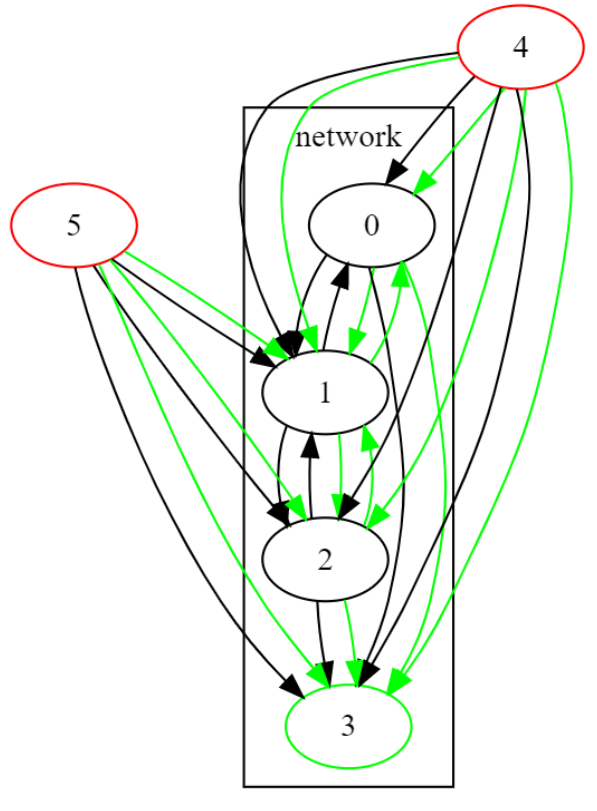
Figure 4. The full graph of instance TinyInstance.